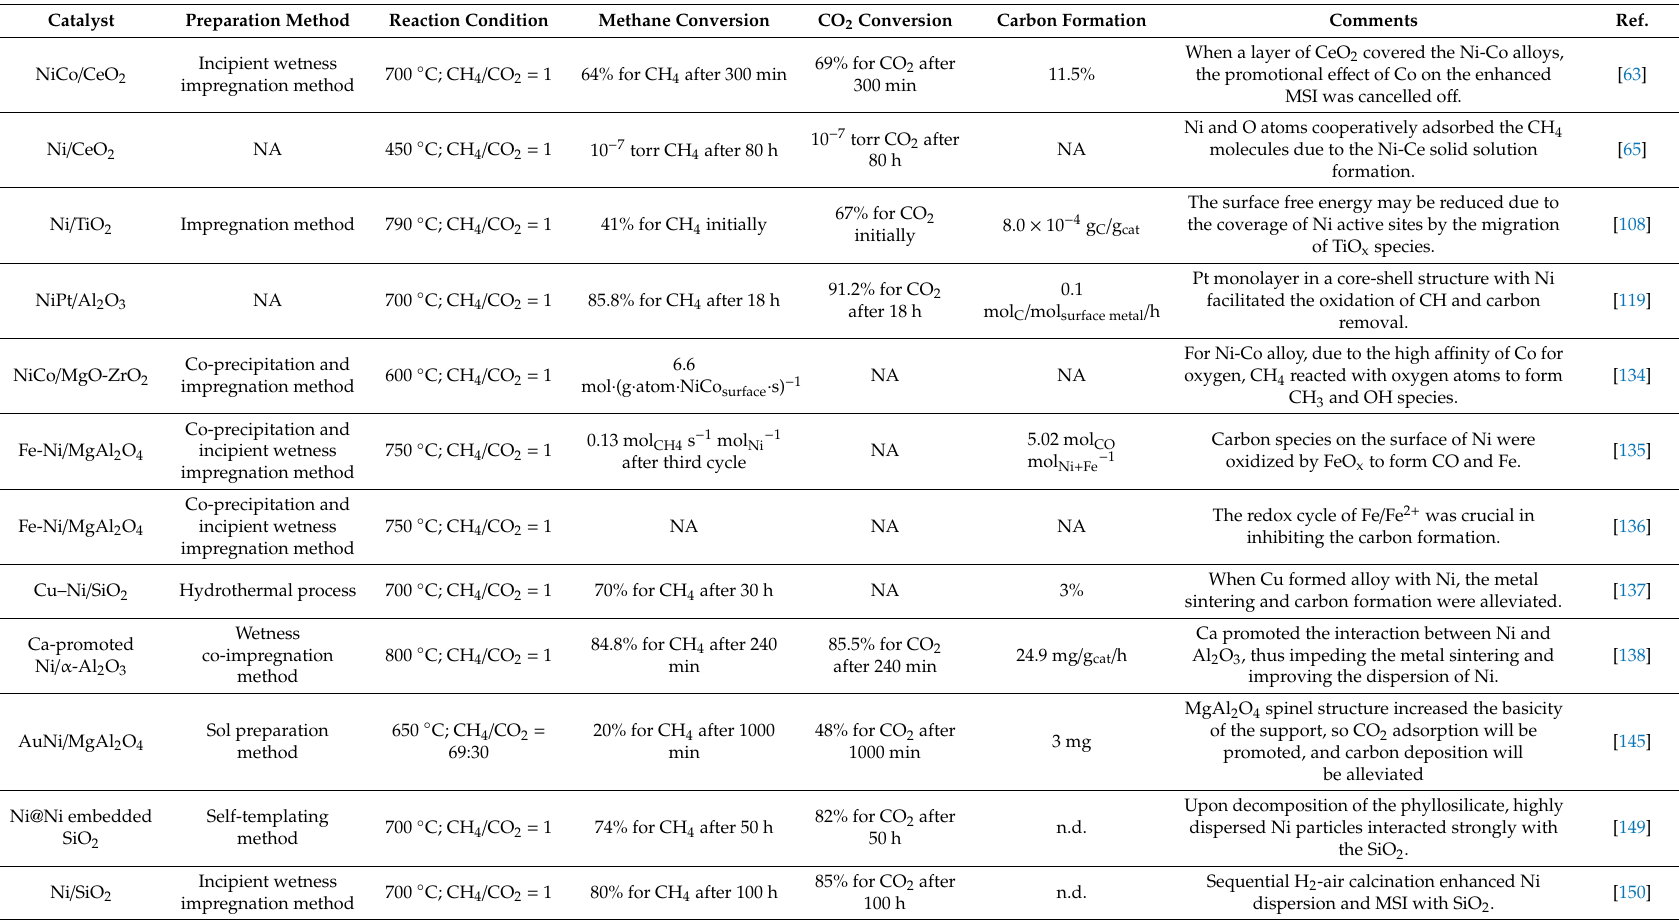
Table 3. A summary of interfacial engineering e ff ects on the catalytic performances of Ni-based catalysts for DRM